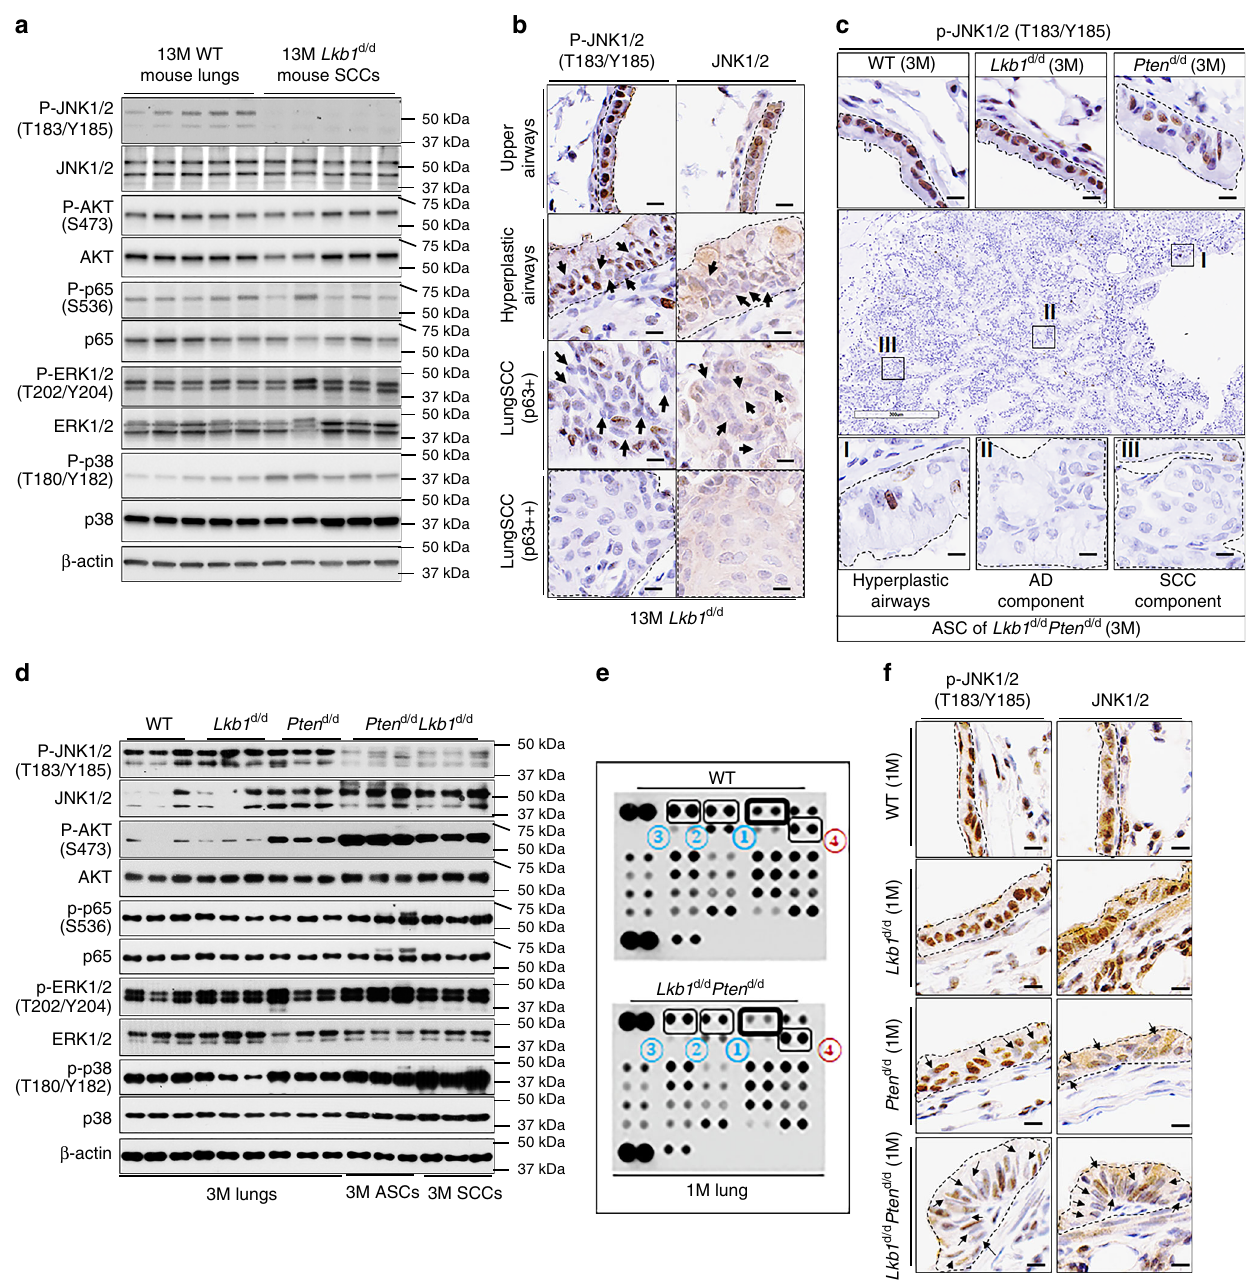
Fig. 2 p-JNK1/2 are reduced in Lkb1 -de fi ciency-driven mouse LSCC development. a Western blot (WB) analysis ( n = 5) of protein expression in 13-month-old (13M) Lkb1 d/d mice. b Representative P-JNK1/2 and JNK1/2 IHC staining of mouse lungs ( n = 6). Dashes outline regions of interest. P-JNK1/2 staining is usually nuclear while JNK1/2 staining is usually cytoplasmic and nuclear. c Representative IHC staining results of P-JNK1/2 in 3-month-old mouse lungs and lung tumors ( n = 6). Black dashes point to the areas of interest. Box I: hyperplastic airway; Box II: adenocarcinoma (AD) component; Box III: peripheral squamous cell carcinoma (SCC) component. Scale bar: 300 μ m (black box) and 10 μ m (dark bar). d WB analysis of 3-month-old (3M) mouse lungs and lung tumors. e Kinome array was performed in 1-month-old (1M) mouse lungs ( n = 6) (see Supplementary Fig. 4b for a full summary of kinome array). The dots in the membranes are anti-phosphorylated (P)-proteins and the numbers pointing out the top changed proteins were listed in Table 3. f Representative IHC staining of P-JNK1/2 and JNK1/2 in 1-month-old mouse lungs ( n = 5). Arrows point to the cells with weak nuclear staining. Scale bar: 300 μ m (Black box) and 10 μ m (dark